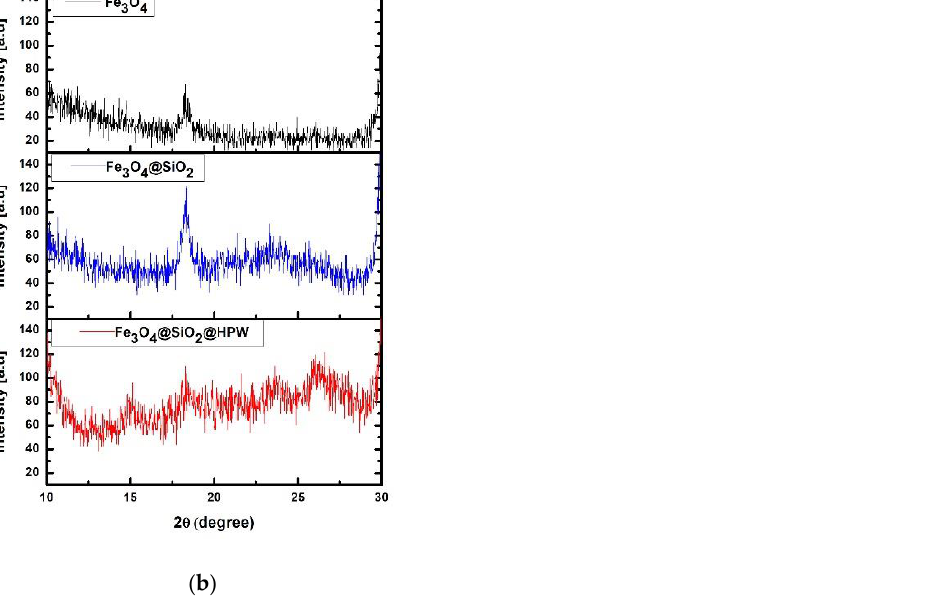
Figure 9. The pore size distribution of Fe 3 O 4 , Fe 3 O 4 @ SiO 2 , and Fe 3 O 4 @ SiO 2 @HPW . Table 3 presents the values of the parameters that define the textural properties of the catalyst, namely the BET-specific area, the meso- and macro-pore volume, and the mean diameter. In the Fe 3 O 4 @SiO 2 @HPW catalyst, the BET surface area (40.86 m 2 /g) and pore volume (0.24 cm 3 /g) were decreased due to immobilization HPW molecules and structural rearrangement after catalyst calcination through -OH group elimination.